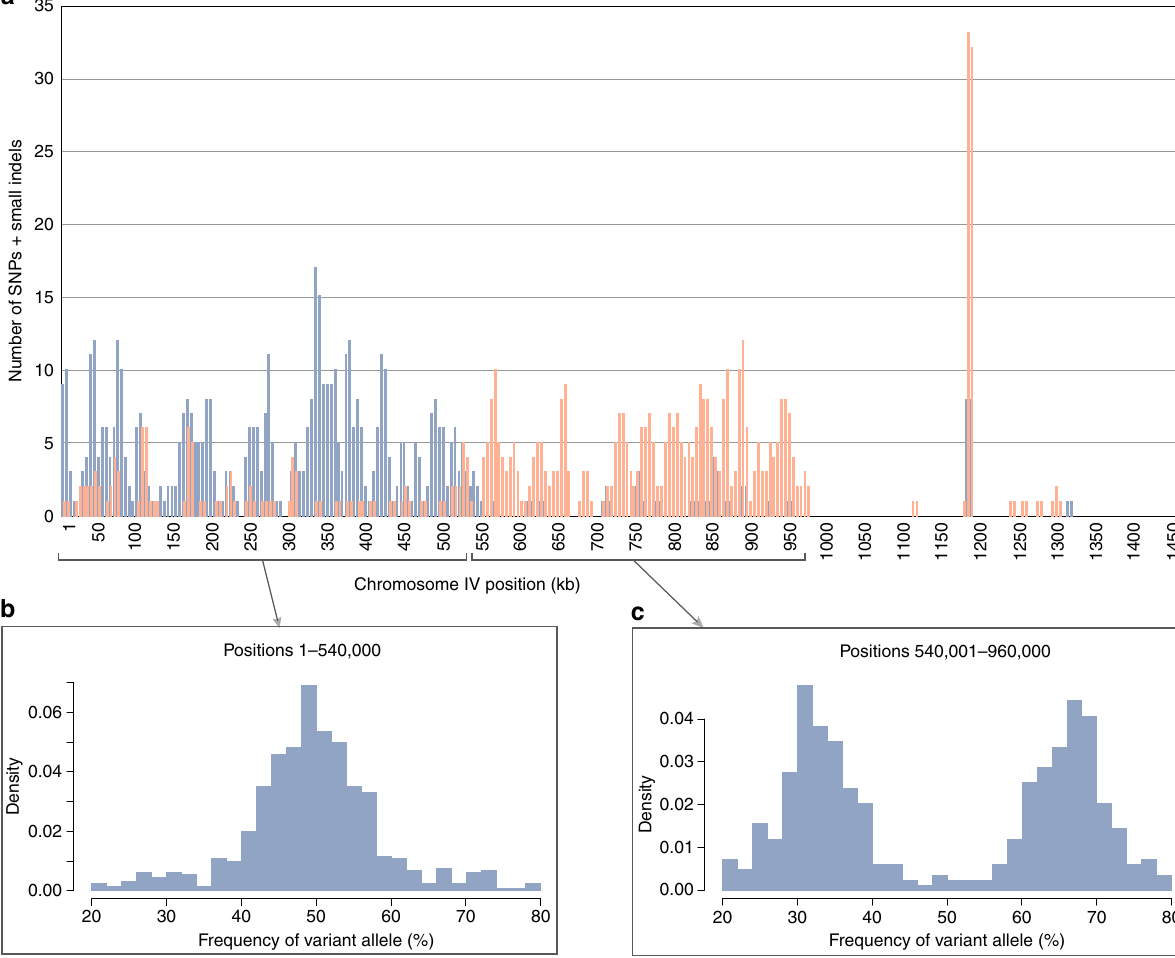
Fig. 5 Clustering of SNPs and small indels strongly departing from the 1:1 allelic ratio on chromosome IV. a Distribution of polymorphic sites with allelic frequencies falling in the following categories: 40 – 60% (blue) and 20 – 39% + 61 – 80% (orange). b Allelic frequency distribution observed in the segment delimited by positions 1 – 540,000. c Allelic frequency distribution observed in the segment delimited by positions 540,001 – 960,000. Source data are provided as a Source Data fi